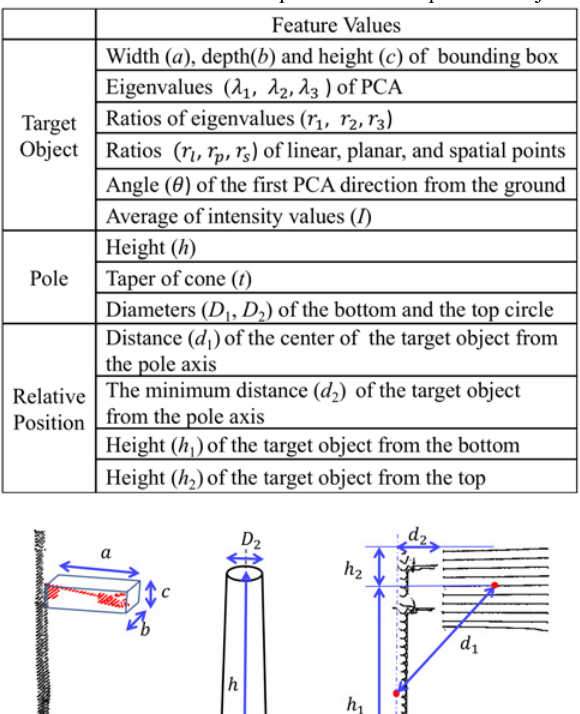
Table 1. Feature values of the point-cloud of a pole-like object